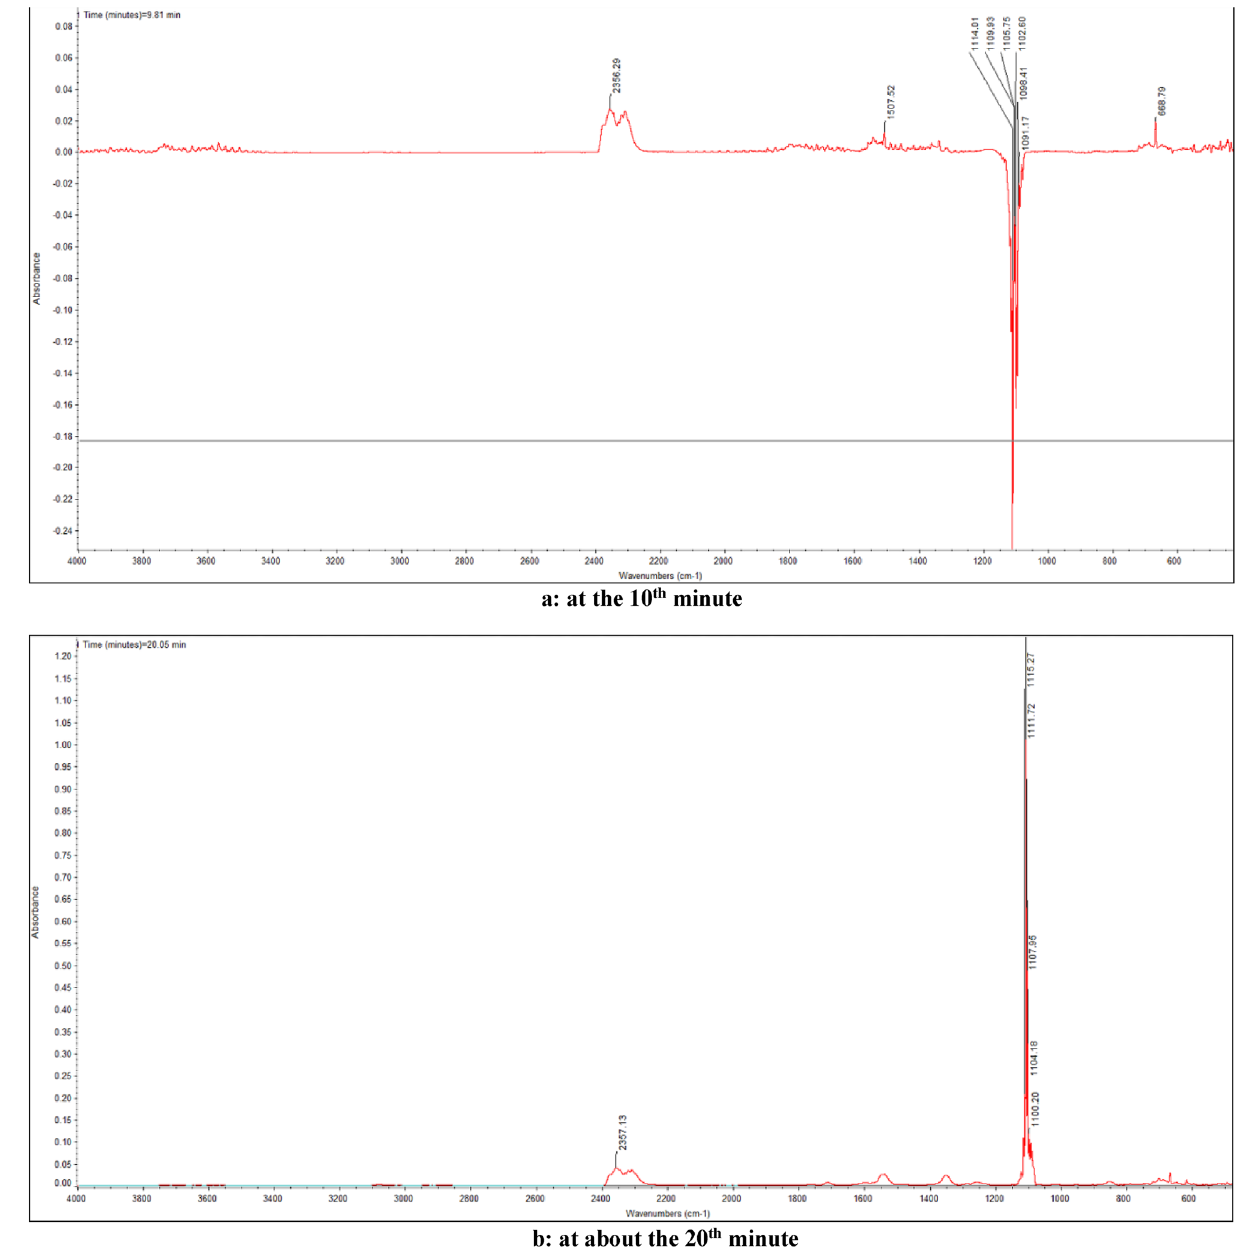
Figure 8. FTIR of gas products from thermal decomposition of 1-nitroso-2-naphthol at the 10 th minute and the 20th